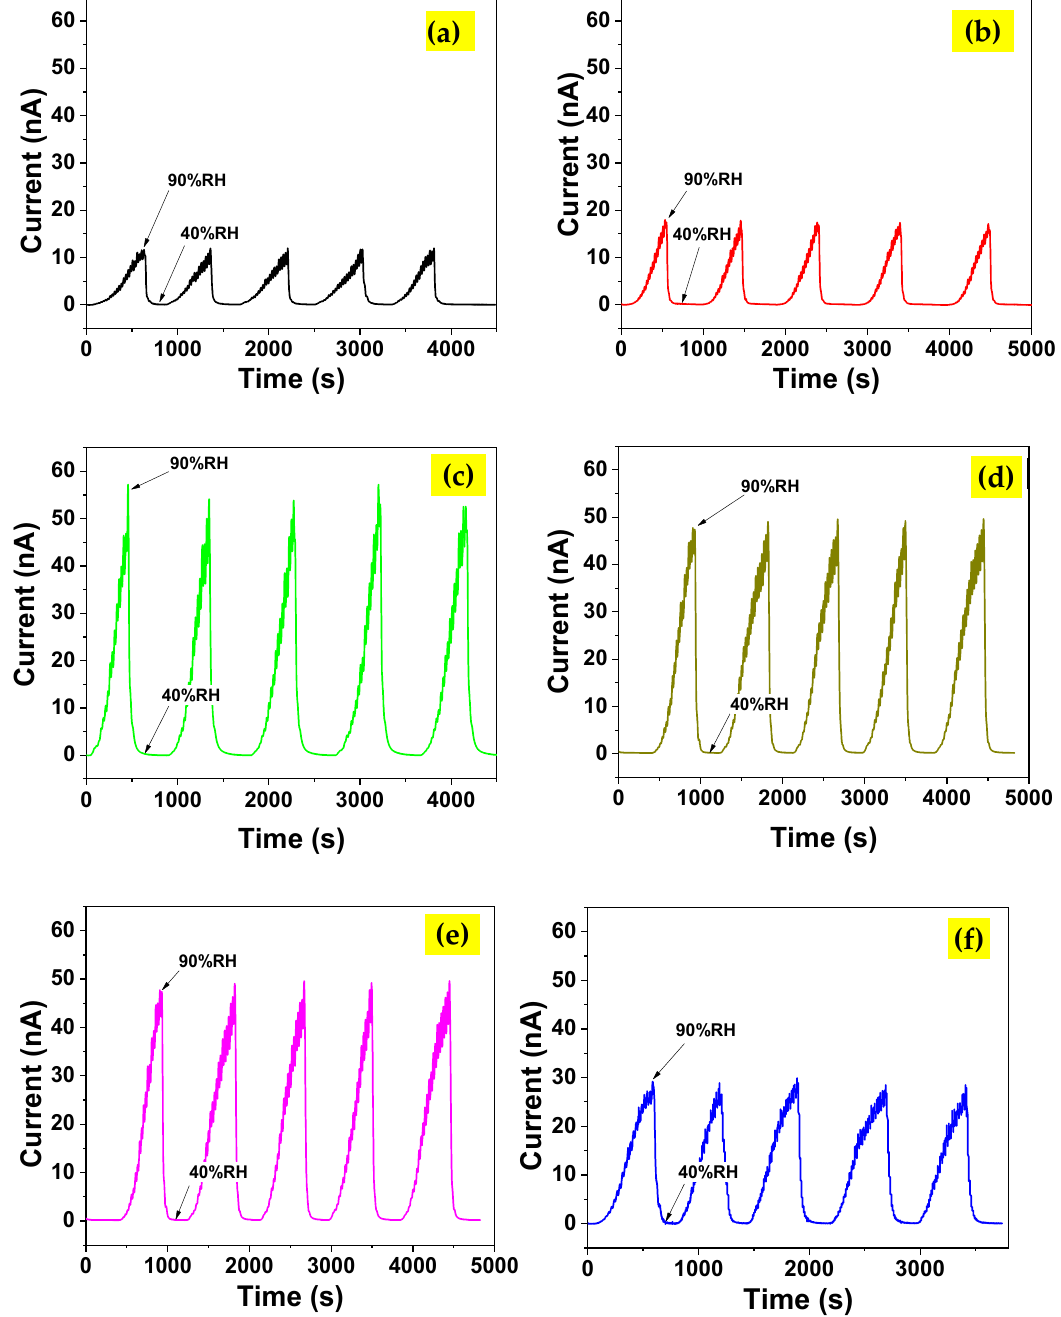
Figure 6. Humidity sensing response of ( a ) UTD, ( b )TAFM-1, ( c ) TAFM-3, ( d ) TAFM-5, ( e ) TAFM-7, and ( f ) TAFM-9.